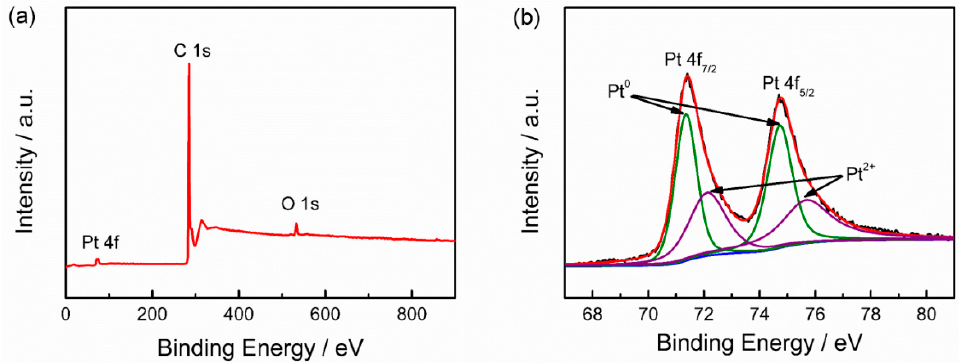
Figure 4. ( a ) Survey XPS spectrum and ( b ) Pt 4f spectrum of Pt NCs/CNTs-10%.